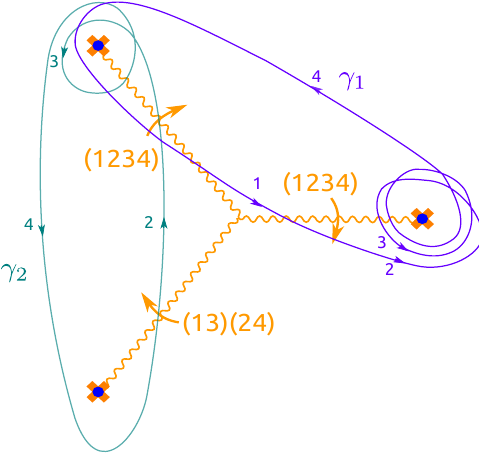
Figure 1 . Homology classes on (cid:6) representing the primitive electric charge (cid:13) 1 and primitive magnetic charge (cid:13) 2 . The purple cycle is the primitive electric charge (cid:13) 1 and the green cycle is the primitive magnetic charge (cid:13) 2 . The intersection number h (cid:13) 1 ; (cid:13) 2 i is 1. The wavy lines carrying permutations are the branch cuts in our presentation of (cid:6) as a 4-fold covering of the plane. The three punctures are at z 1 = 1, z 2 = ! and z 3 = ! 2 . The numbers on each path segment indicate which sheet the path is